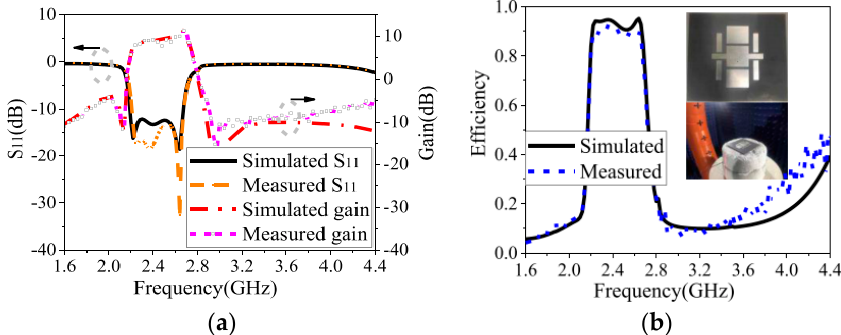
Figure 10. The filtering antenna design reproduced from [71]. 2020, IEEE: ( a ) S-parameter and gain; ( b ) efficiency and a photograph of the fabricated prototype.